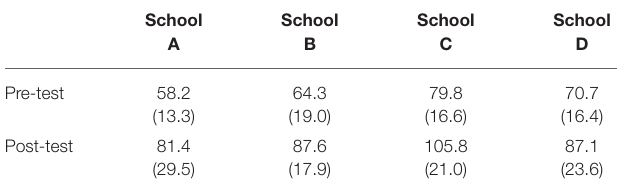
TABLE 4 | Results from the knowledge tests presented as means for each of the schools (in